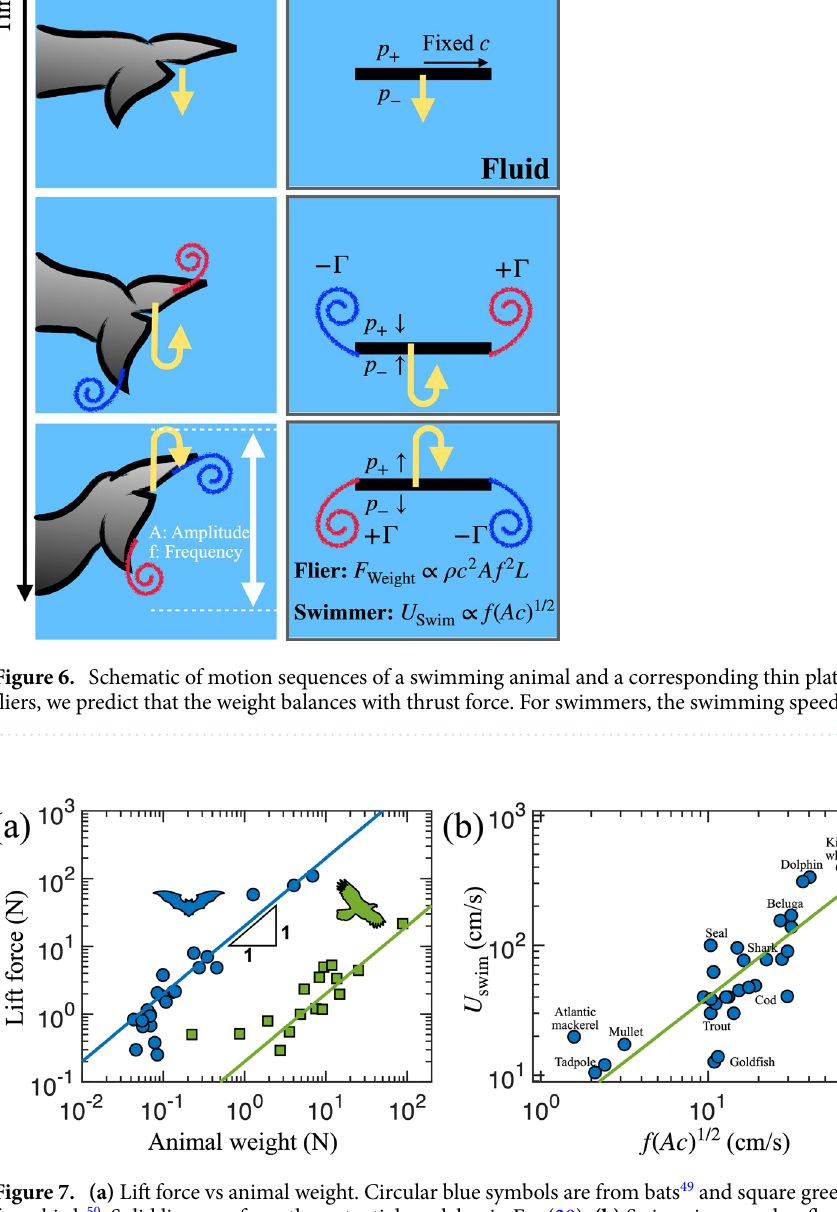
Figure 7. (a) Lift force vs animal weight. Circular blue symbols are from bats 49 and square green symbols are from birds 50 . Solid lines are from the potential model as in Eq. (28). (b) Swimming speed vs flapping speed from tadpoles to whales 52–71 . The solid line is from the potential model for swimmers as in Eq.